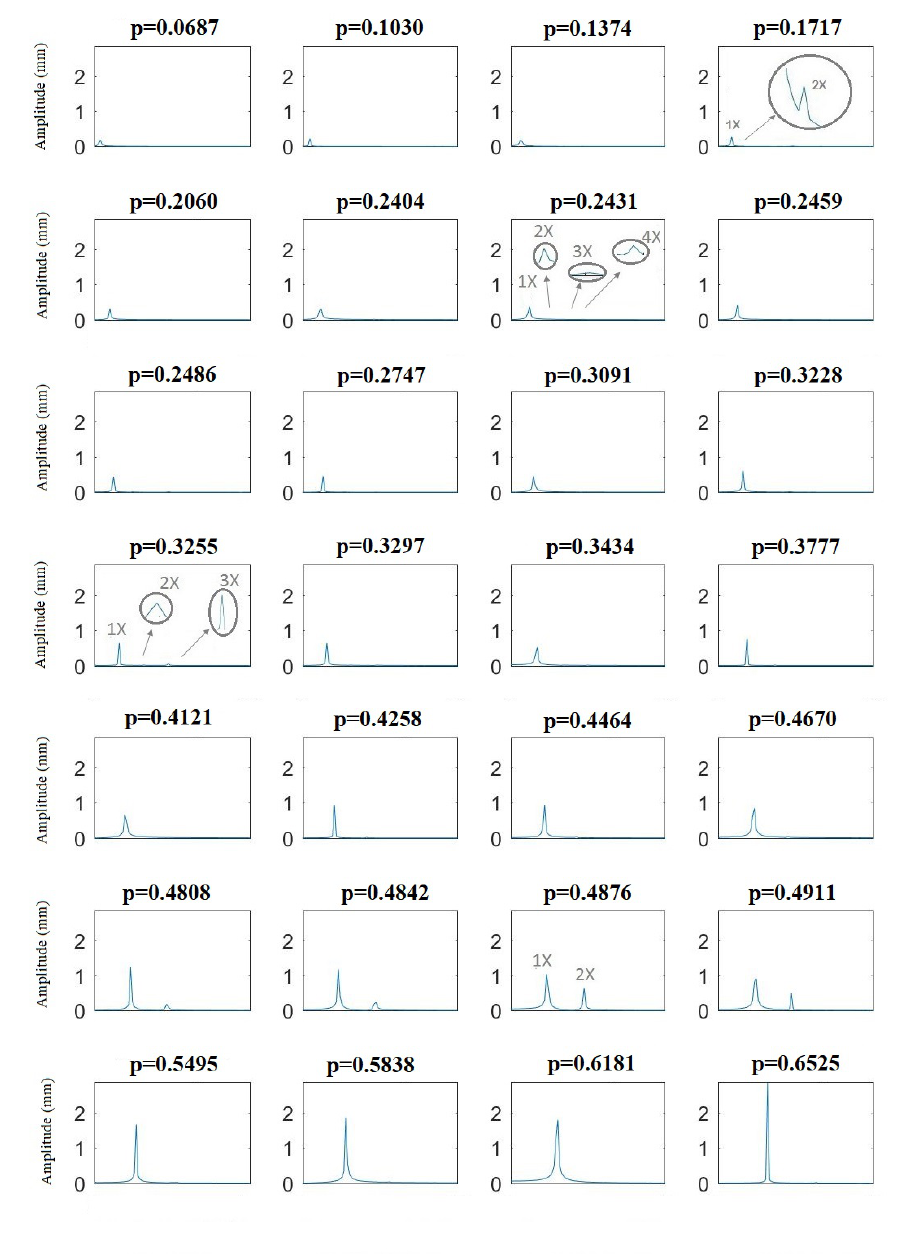
Figure 20. FFT of the vertical displacement at different rotation speeds for the case of α =